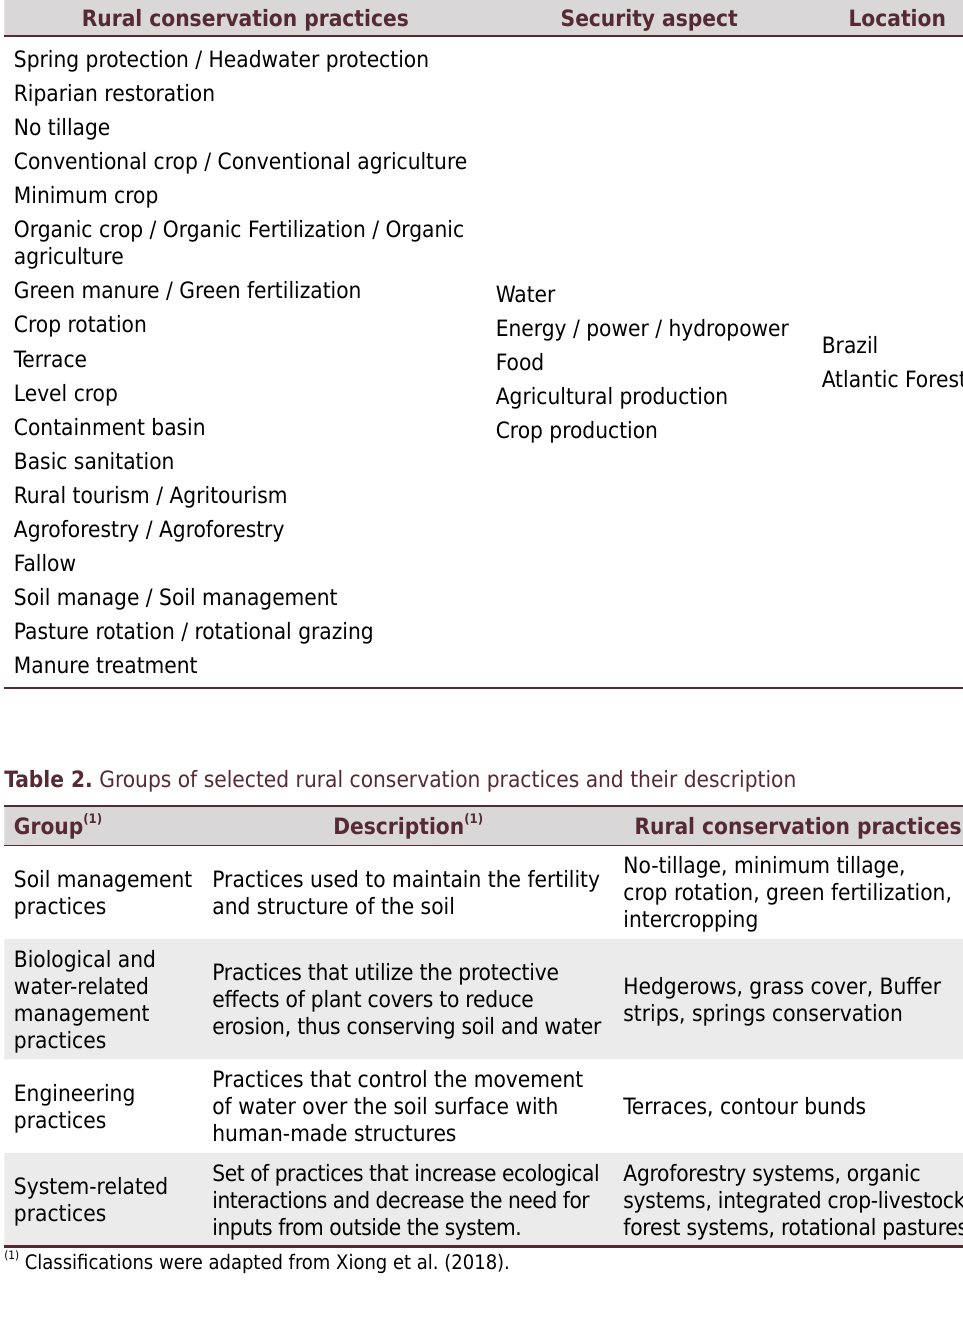
Table 1. Keywords used to search for articles that were investigating the impact of at least one rural conservation practice on one security within the Brazilian biome of interest Keywords used in the research